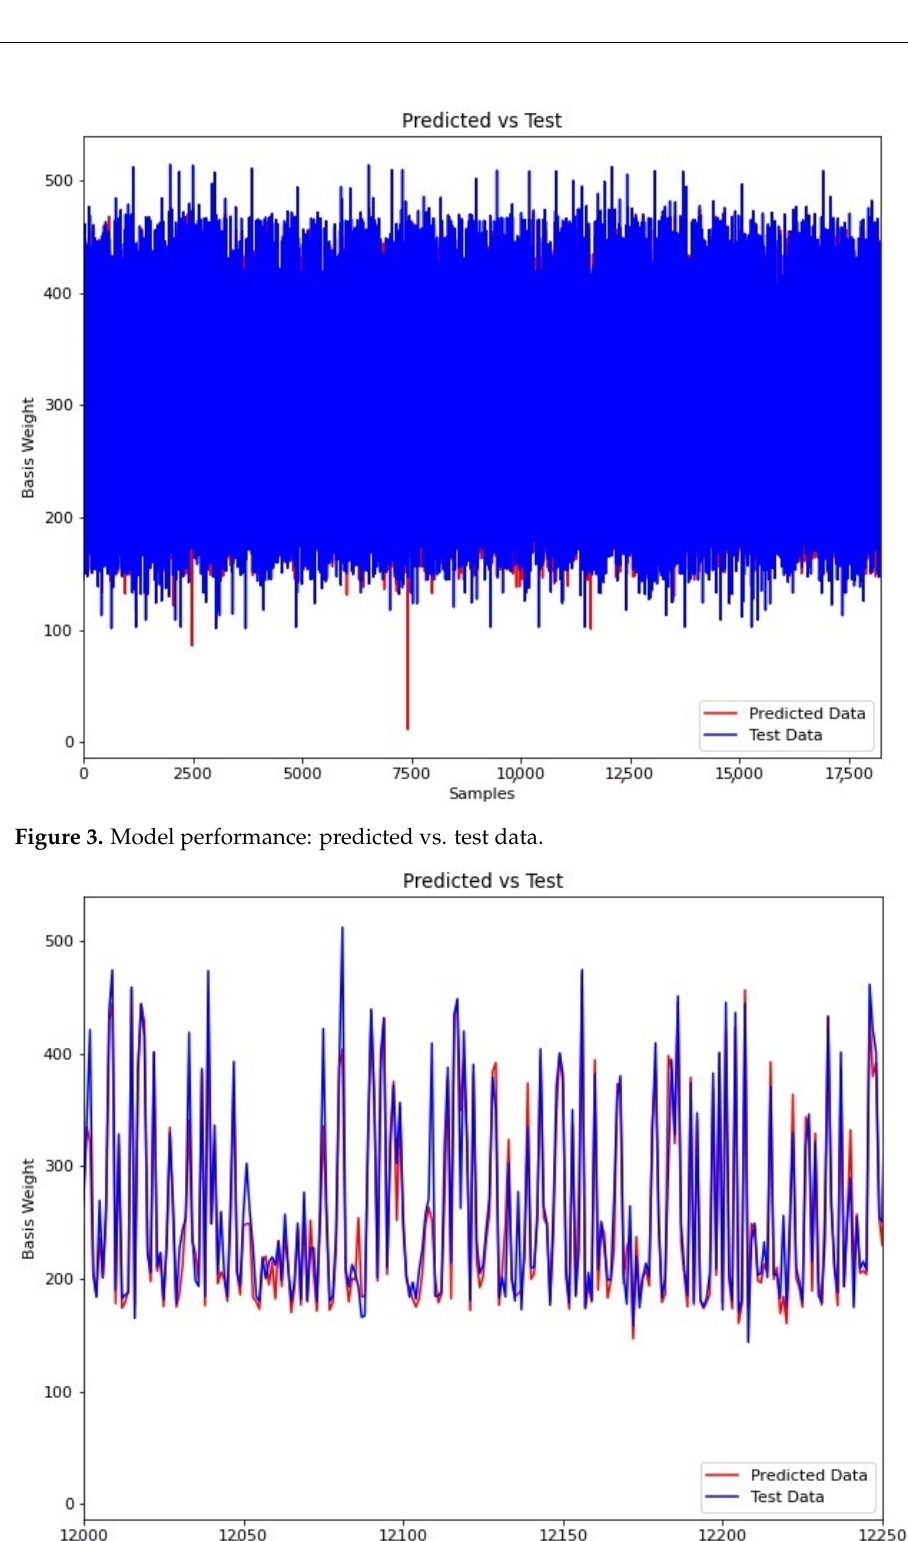
Figure 4. Predicted vs. test data selected from 12,000 to 12,250.